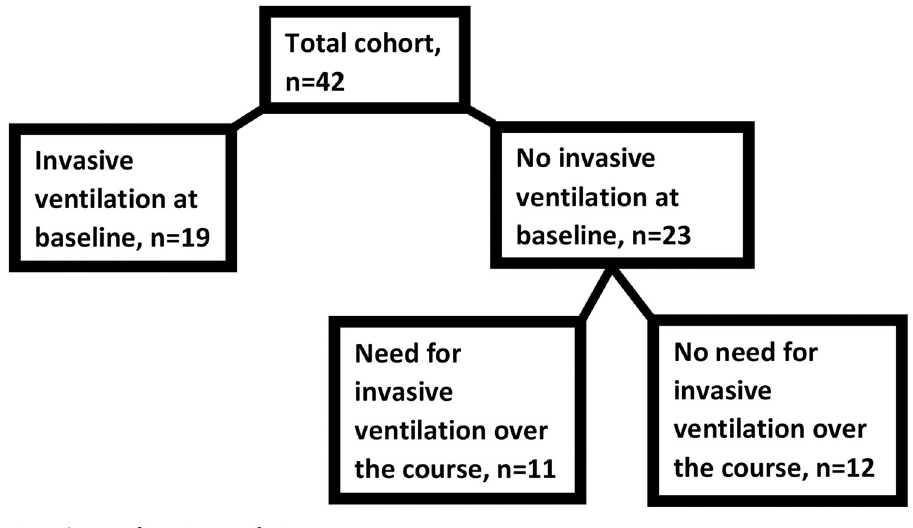
Fig 2. Course of invasive ventilation.